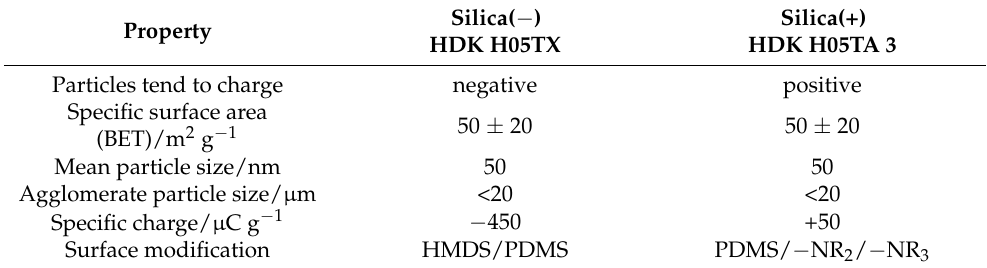
Table 1. Material properties of HDK H05XT and HDK H05TA according to the manufacturer. Silica( − ) Silica(+) Property HDK H05TX HDK H05TA 3 Particles tend to charge negative positive Specific surface area 50 ± 20 50 ± 20 (BET)/m 2 g − 1 Mean particle size/nm 50 50 Agglomerate particle size/ µ m <20 <20 Specific charge/ µ C g − 1 − 450 Surface modification HMDS/PDMS